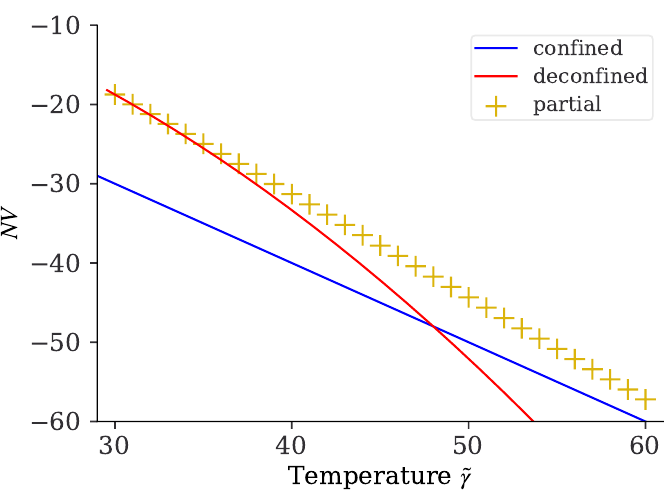
Figure 3. Free energy V times N versus “temperature” ˜ γ in the Abelian N = ∞ limit, for any θ . We show NV of the confined phase from eq. (2.22) (blue line), the deconfined phase from eq. (2.32) (red line), and our numerical results for the partial phase (gold plus signs). We find the “swallow- tail” shape characteristic of a first-order phase transition, with the partial phase as the unstable branch connecting the confined and deconfined